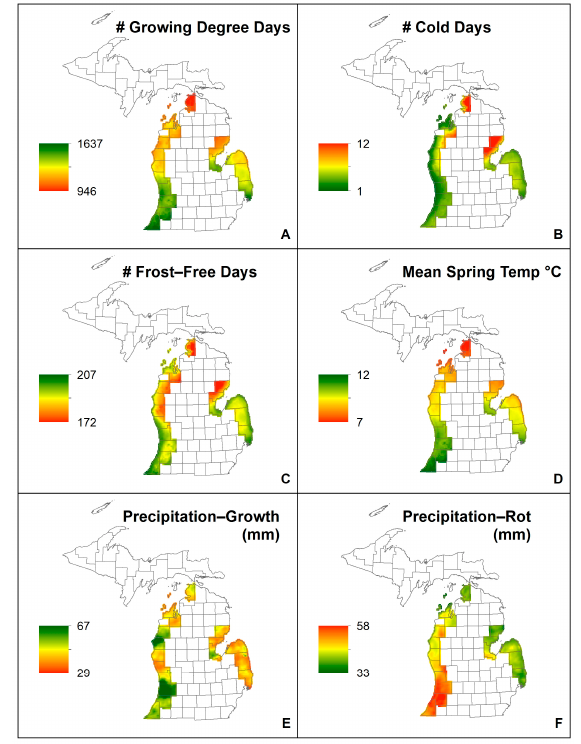
Figure 2. Spatial patterns of the six climate-based variables used in the modeling efforts: ( A ) mean accumulated growing degree days from April to October, ( B ) mean frequency of cold days less than or equal to − 20 ◦ C each year, ( C ) mean number of frost free days between last spring frost and the first fall frost, ( D ) mean spring temperature ( ◦ C), ( E ) mean accumulated precipitation during the key grape growth period, and ( F ) mean amount of precipitation during the critical period before harvest when grapes are vulnerable to